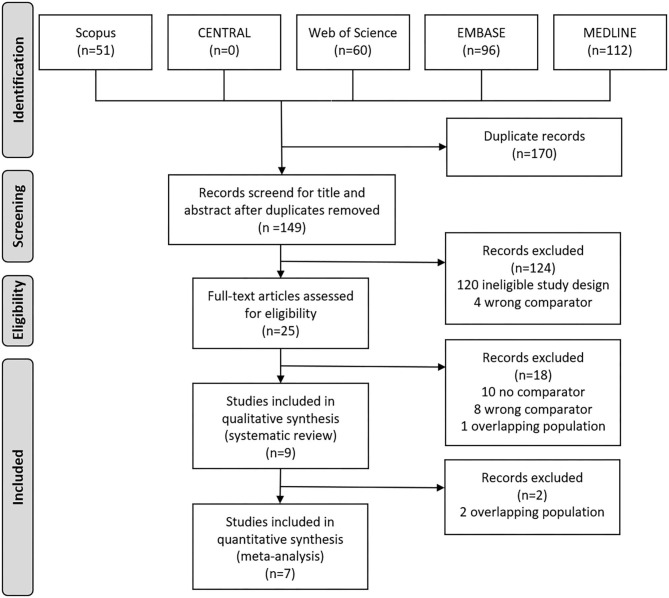
Preferred Reporting in Systematic Reviews and Meta-analyses (PRISMA) flowchart showing the selection process.